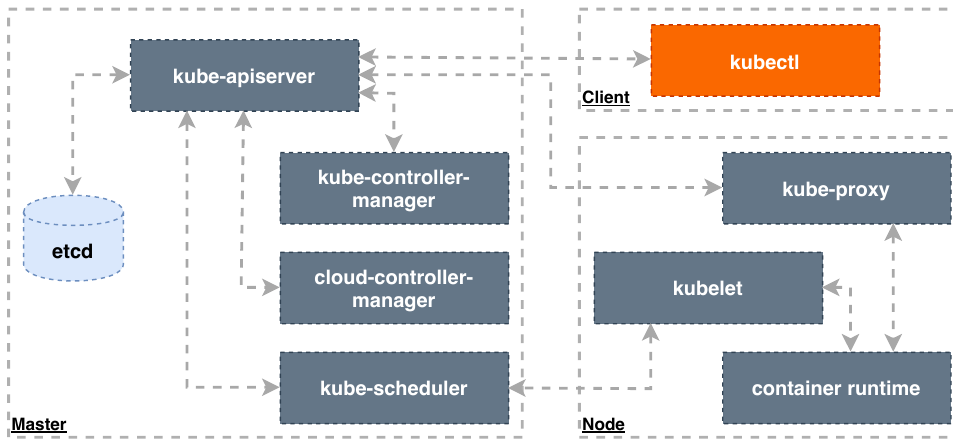
Figure 12. Kubernetes architecture components, adapted from